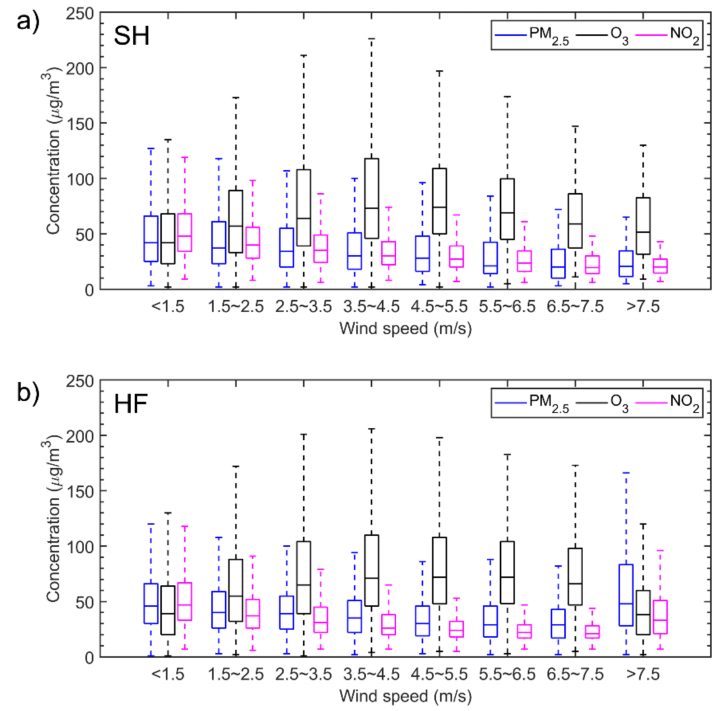
Figure 5. Box and whiskers plot of hourly mean concentrations of PM 2.5 , O 3 , and NO 2 in each category of wind speed in ( a ) Shanghai (SH) and ( b ) Hefei